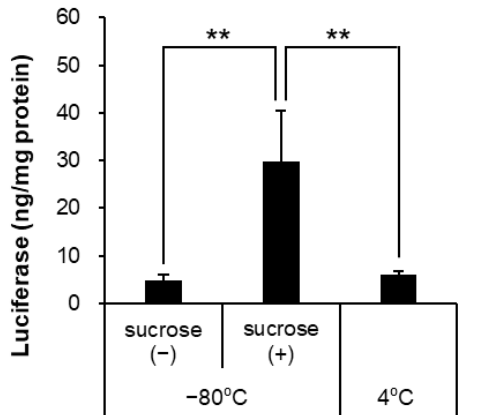
Table 3. Effects of the cryoprotectants on particle properties of the mRNA encapsulating LNPs.